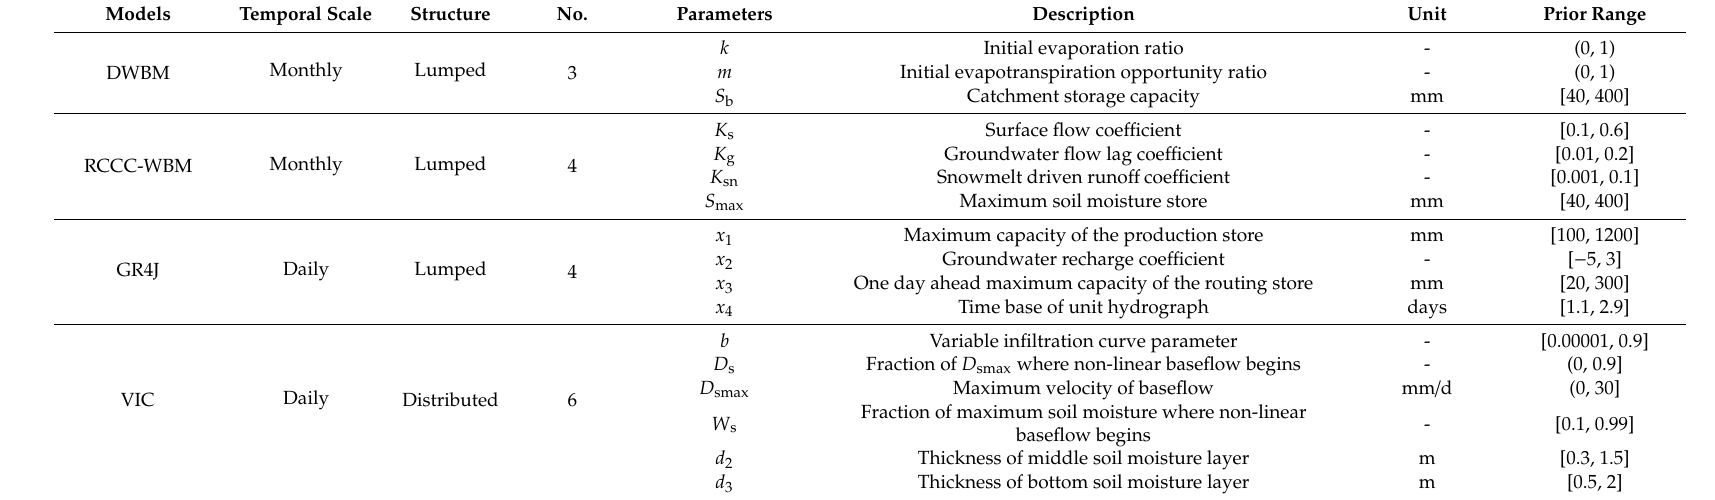
Table 3. The four hydrological models and their